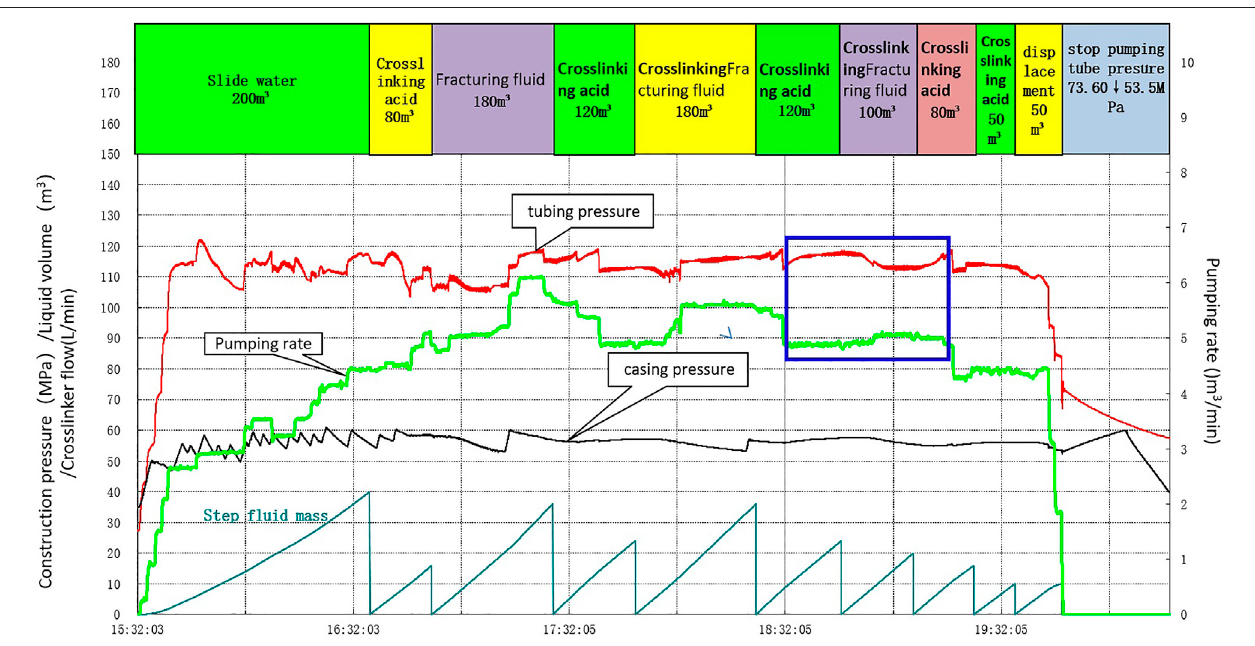
FIGURE 8 | Curve of the acid-fracturing stimulation in 8,203.00 – 8,260.00 m ( Section 3 ), and the relationship between tubing pressure and pumping rate described in the blue rectangular box indicates that when the pumping rate is stable, the tubing pressure increases and then decreases, and when the pumping rate increases, the tubing pressure is lower, indicating that the formation is stimulated to generate new hydraulic fractures or the pre-existing natural fractures are activated.